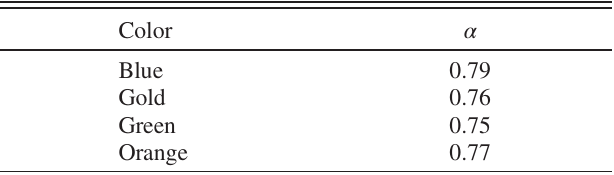
TABLE II. Cronbach ’ s α of the color score for each of the five groups of word